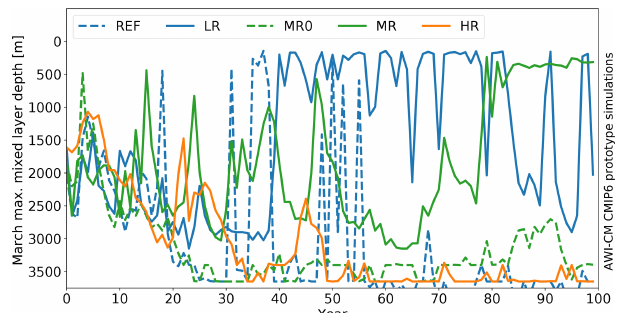
Figure A1. Maximum mixed layer depth [m] for March in the Labrador Sea for the five 100-year simulations with AWI-CM. The simulated mixed layer starts to diverge after about 20–30 years into the coupled simulations. At the end of the simulation (years 71– 100), LR and MR have the lowest mixed layer, while REF, MR0, and HR simulate overly deep mixed layers in the Labrador Sea.